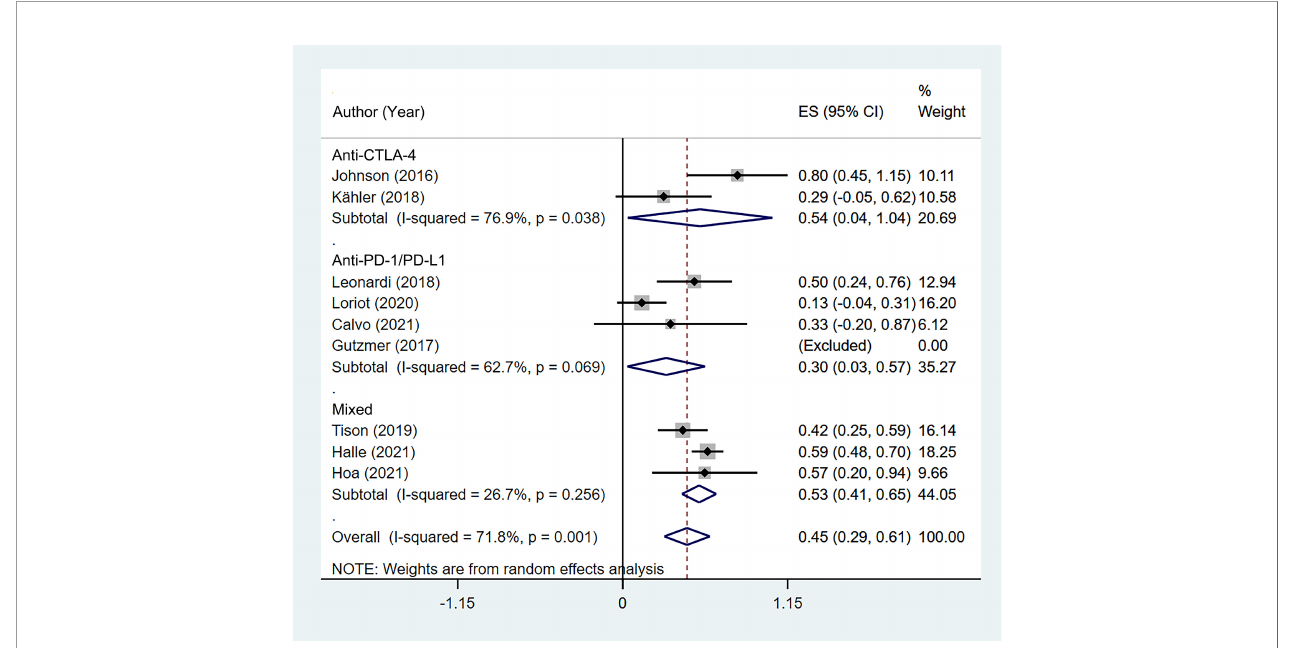
FIGURE 5 | Subgroup analysis of the pooled incidence of de novo immune-related adverse event (irAE) in patients with cancer and preexisting psoriasis based on the class of immune checkpoint inhibitors (ICIs).